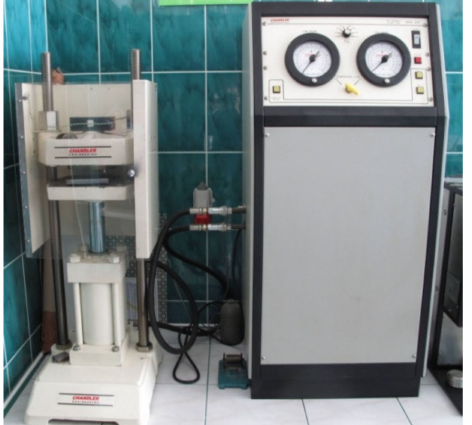
Figure 10. Device for measuring adhesion on the contact of tested surfaces. After each measurement, the adhesion expressed in MPa was calculated according to Equation (1).